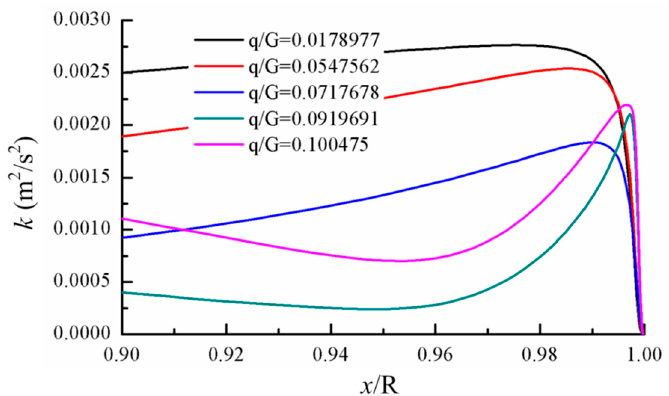
Figure 21. Distribution of the turbulent kinetic energy ( x/D = 39).